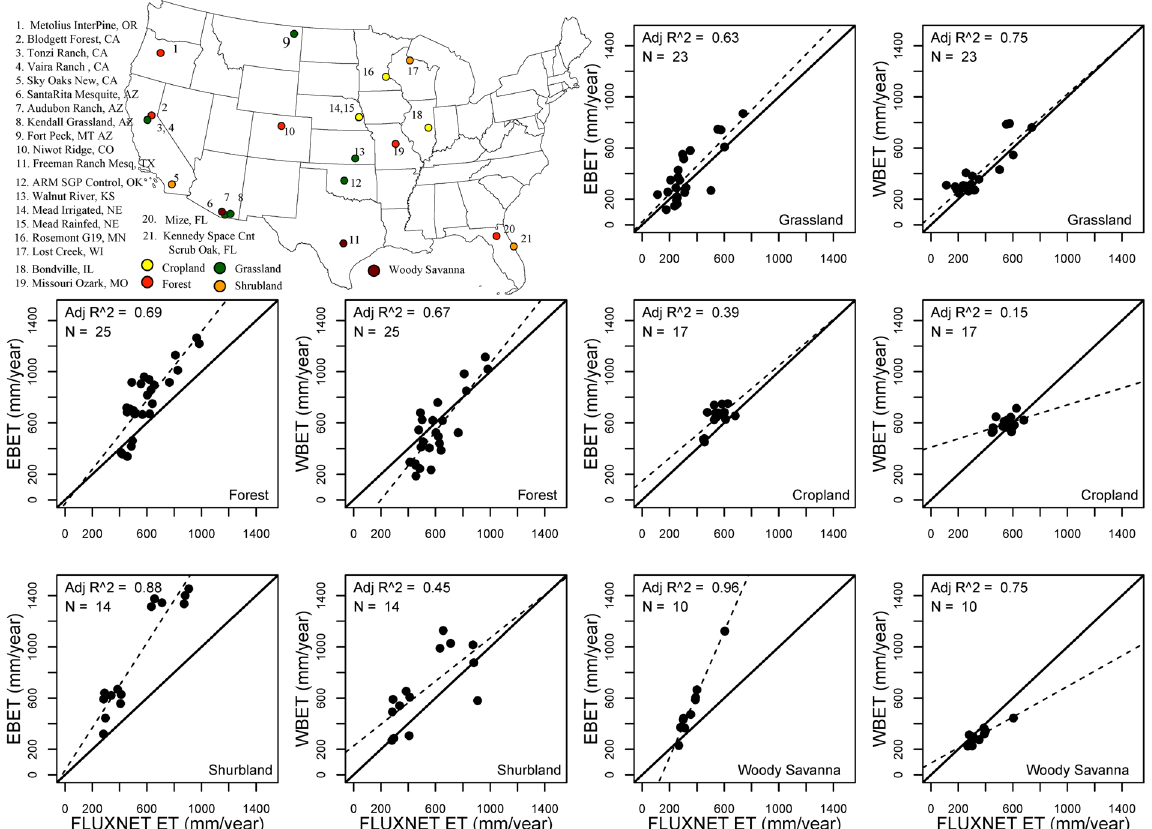
Figure 1. Validation of bias corrected EBET and WBET datasets using data collected over 2001–2007 from 21 FLUXNET sites grouped into five distinct land cover types. The figure was generated using R 3.3.0 software